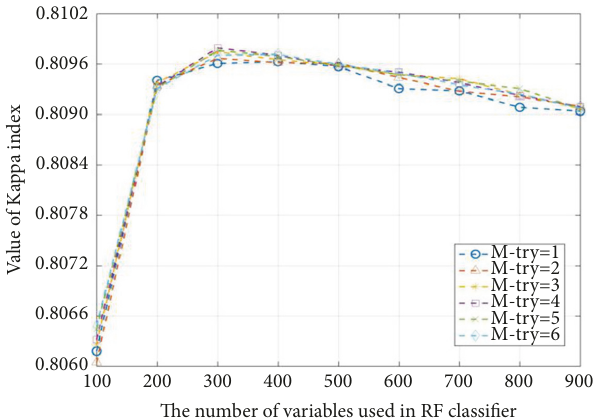
Figure 13: The tendencies of overall accuracy when the N tree and M try are setting different values for